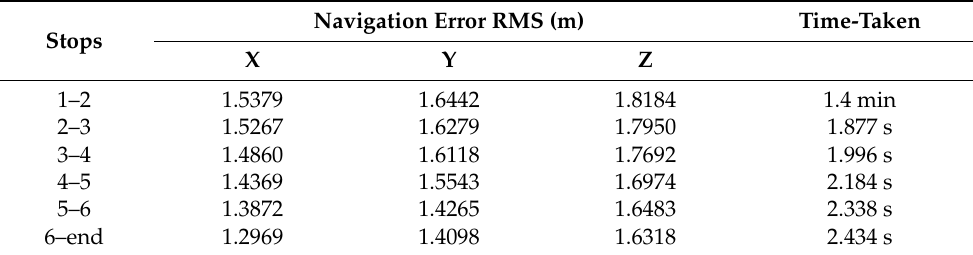
Table 6. The navigation error RMS of the online GMWM algorithm between the two adjacent long stops and the time-taken after long